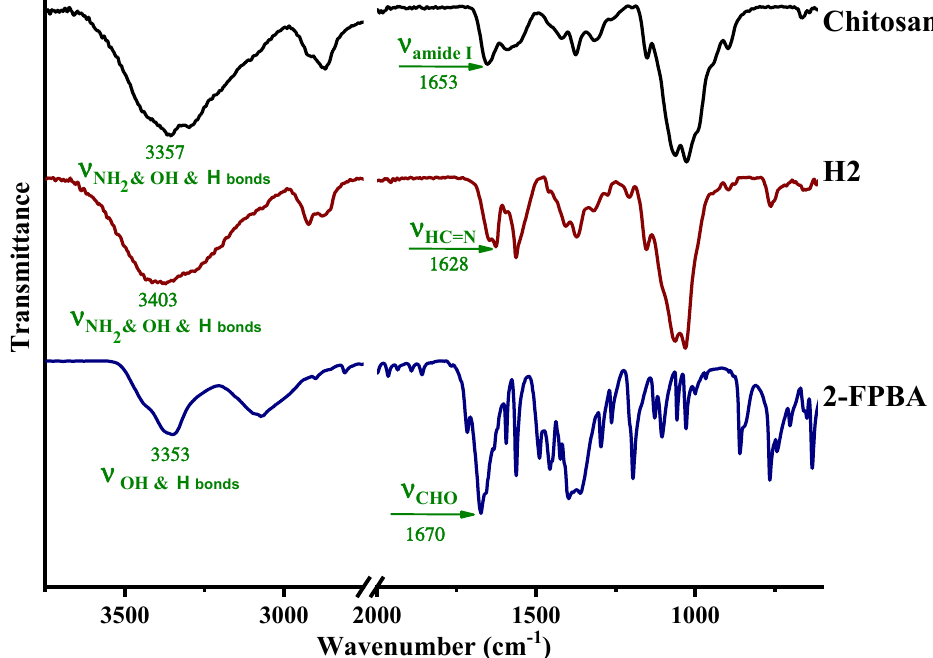
Figure 3. FTIR spectra of the lyophilized hydrogel compared with chitosan and 2-FPBA refer- ences.